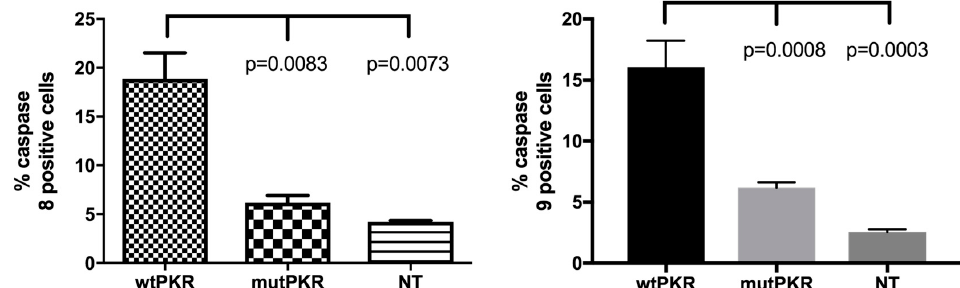
Figure 5. Percentage activated caspase-8 positive cells was about three-fold higher in the wtPKR transfected cells than in mutPKR cells ( p = 0.0083), while activated caspase-9 was 2.5-fold higher in wtPKR compared to mutPKR transfected cells ( p = 0.0008). The p -values for wtPKR versus non-transfected (NT) are also shown while p values for mutPKR versus NT were both >0.05.